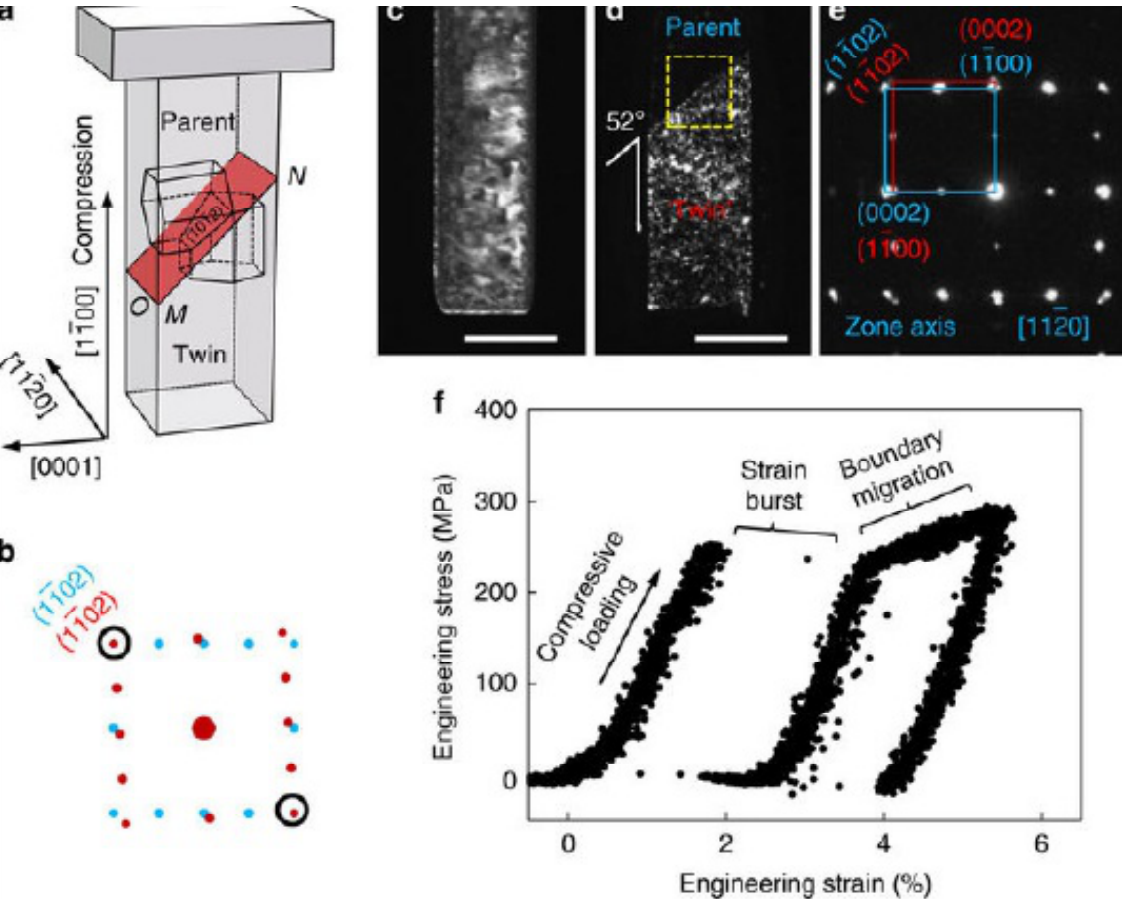
Fig. 34. In situ compression test on a submicron-sized single crystal Mg pillar. (a) Schematic illustration of the crystal, loaded in [1 1 00] orientation. The {10 1 2} plane is highlighted in red. (b) Selected area diffraction pattern (SADP) for an ideal {10 1 2} twin. (c,d) Dark-field TEM images of the pillar before and after compression. Scale bars, 400 nm. (e) SADP taken from the framed area, demonstrat- ing that {10 1 2} diffraction spots are separated instead of overlapping with each other. The zone axis is [11 2 0] for parent lattice. (f) The corresponding stress–strain curve. Reprinted with permission from Liu BY, , Wang J, Li B, Lu L, Zhang XY, et al. 2014. Twinning-like lattice reorientation without a crystallographic twinning plane. Nature Communications 5, [255]. © 2014 Springer